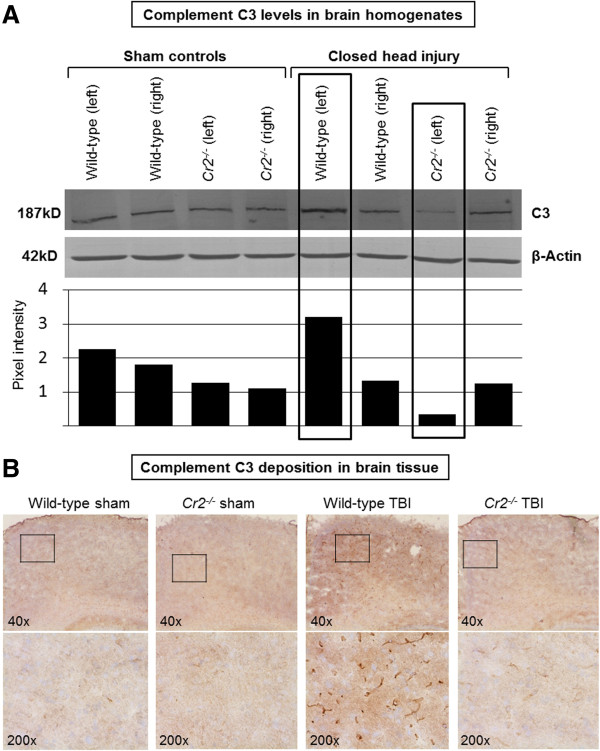
Attenuated intracerebral complement C3 levels in head-injured Cr2-/- mice at 24 hours post injury. Panel A shows a representative western blot of brain homogenates from injured (left) and uninjured (right) hemispheres of wild-type and Cr2-/- mice at 24 hours after head injury or sham surgery, using a monoclonal anti-mouse C3 antibody. Equal protein loading (50 μg per lane) was ensured by control blotting with β-actin. Closed head injury induced an increase of C3 protein levels in the injured hemispheres of wild-type mice compared to sham controls. In contrast, head-injured Cr2-/- mice showed attenuated intracerebral C3 levels in the injured left hemisphere. Pixel intensity for densitometric quantification was determined using ImageJ software. The western blot shown in the figure is representative of four individual experiments. Panel B demonstrates the extent of C3 brain tissue deposition by immunohistochemistry using monoclonal anti-mouse C3 as primary antibody. Similarly as shown by the western blot data, C3 tissue deposition was attenuated in head-injured Cr2-/- mice, compared to wild-type littermates. The inserts in the upper panel (40 ×) reflect the according selection in the corresponding higher magnification images (100 ×). TBI, traumatic brain injury.